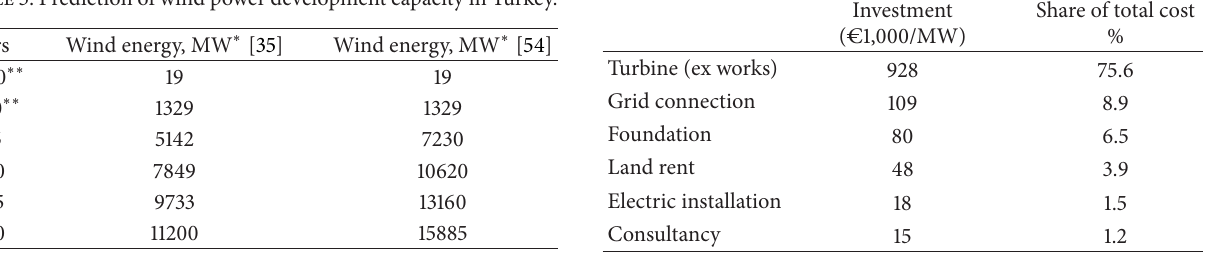
Table 5: Prediction of wind power development capacity in Turkey.